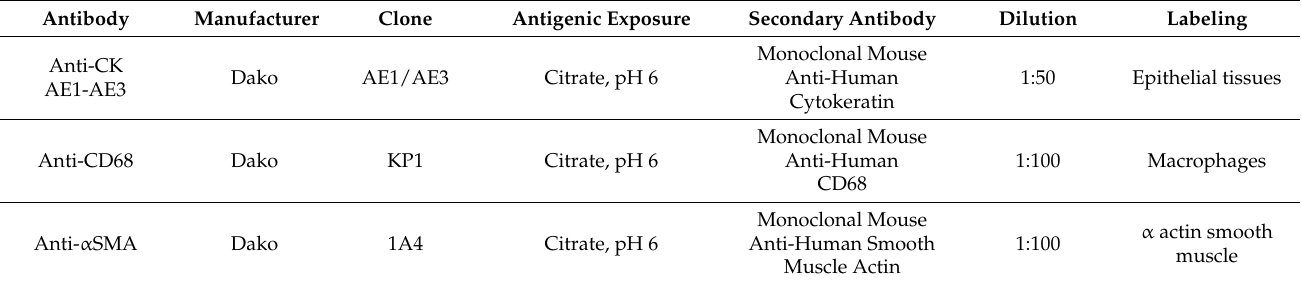
Table 1. Immunohistochemical panel of antibodies used in the